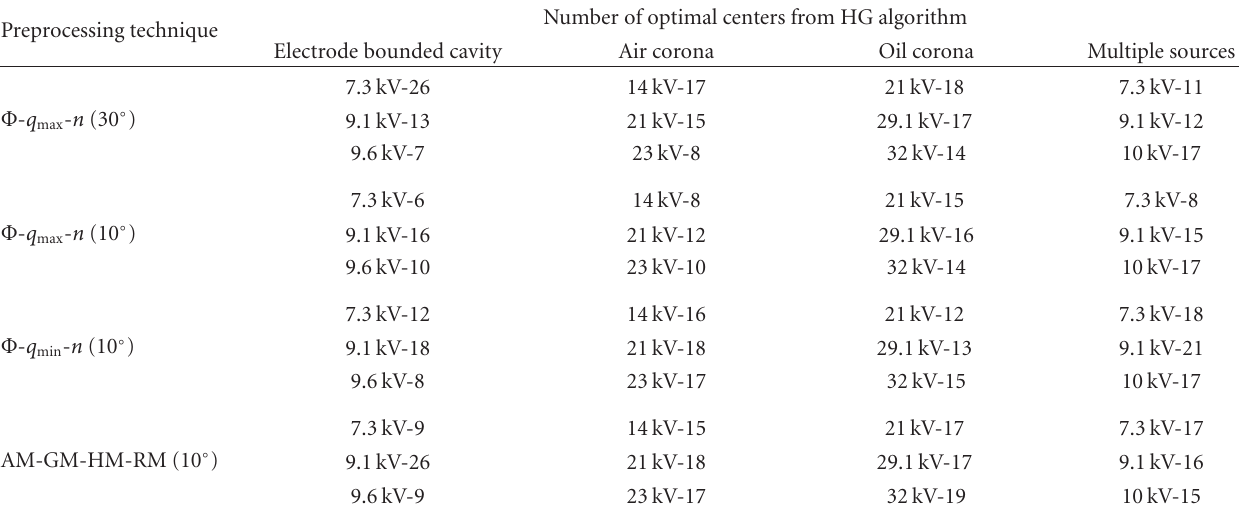
Table 8: Optimal centers obtained from HG algorithm for PD pattern classification.